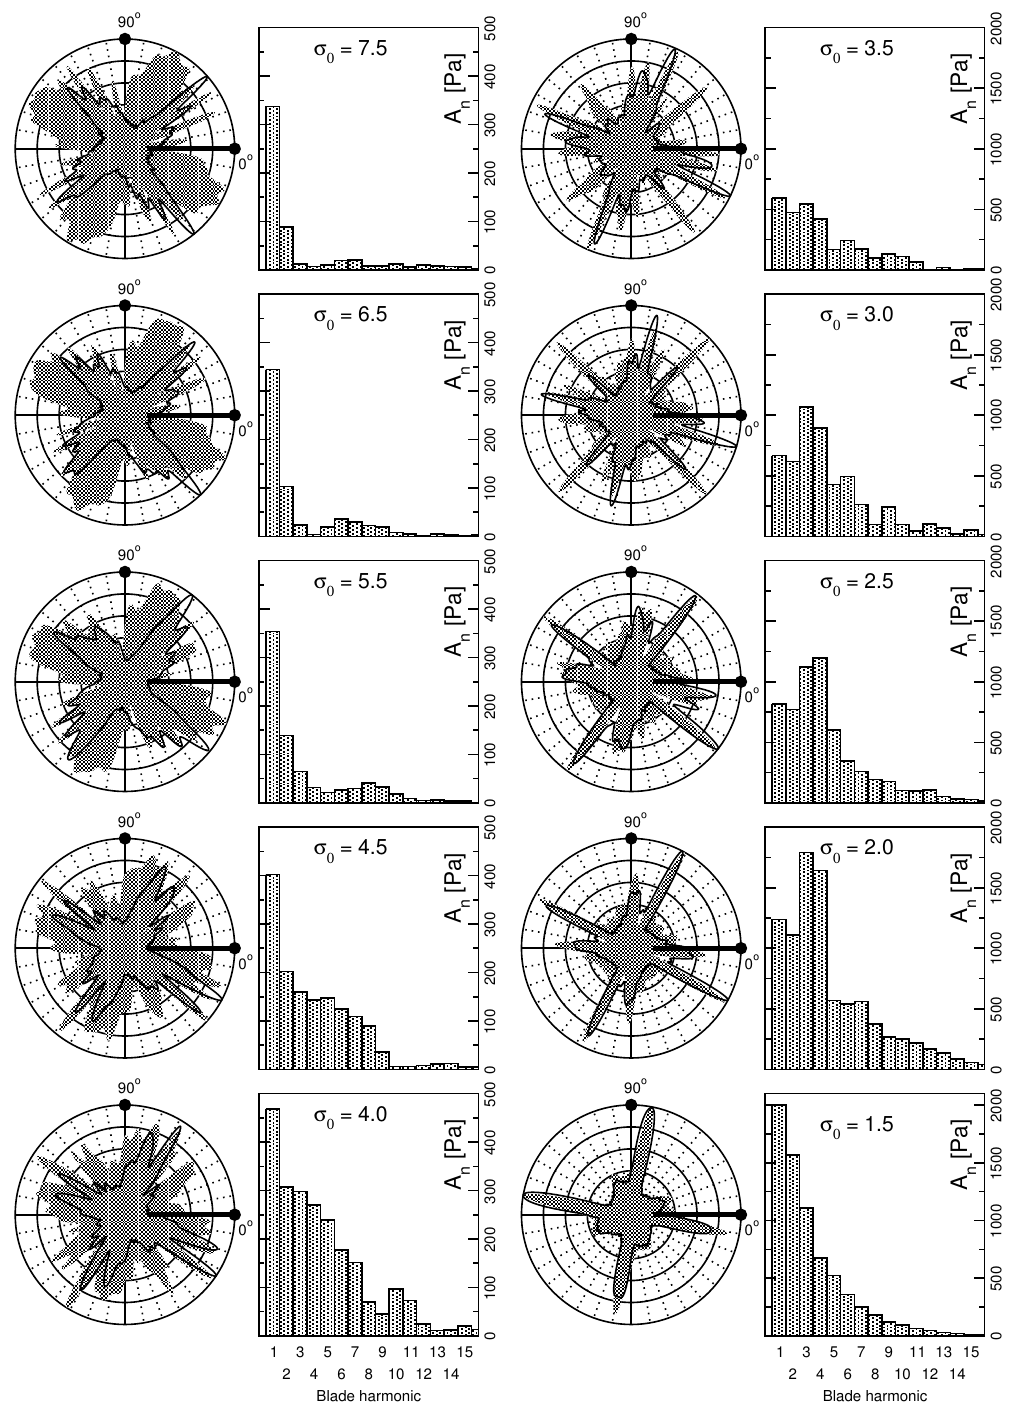
Figure 10. Angular history of the pressure signal from transducer P 2 and corresponding harmonic distribution, for different values of the cavitation number σ 0 . The polar graphs are non-dimensionalized. Grey area: ensemble mean; solid line: ensemble